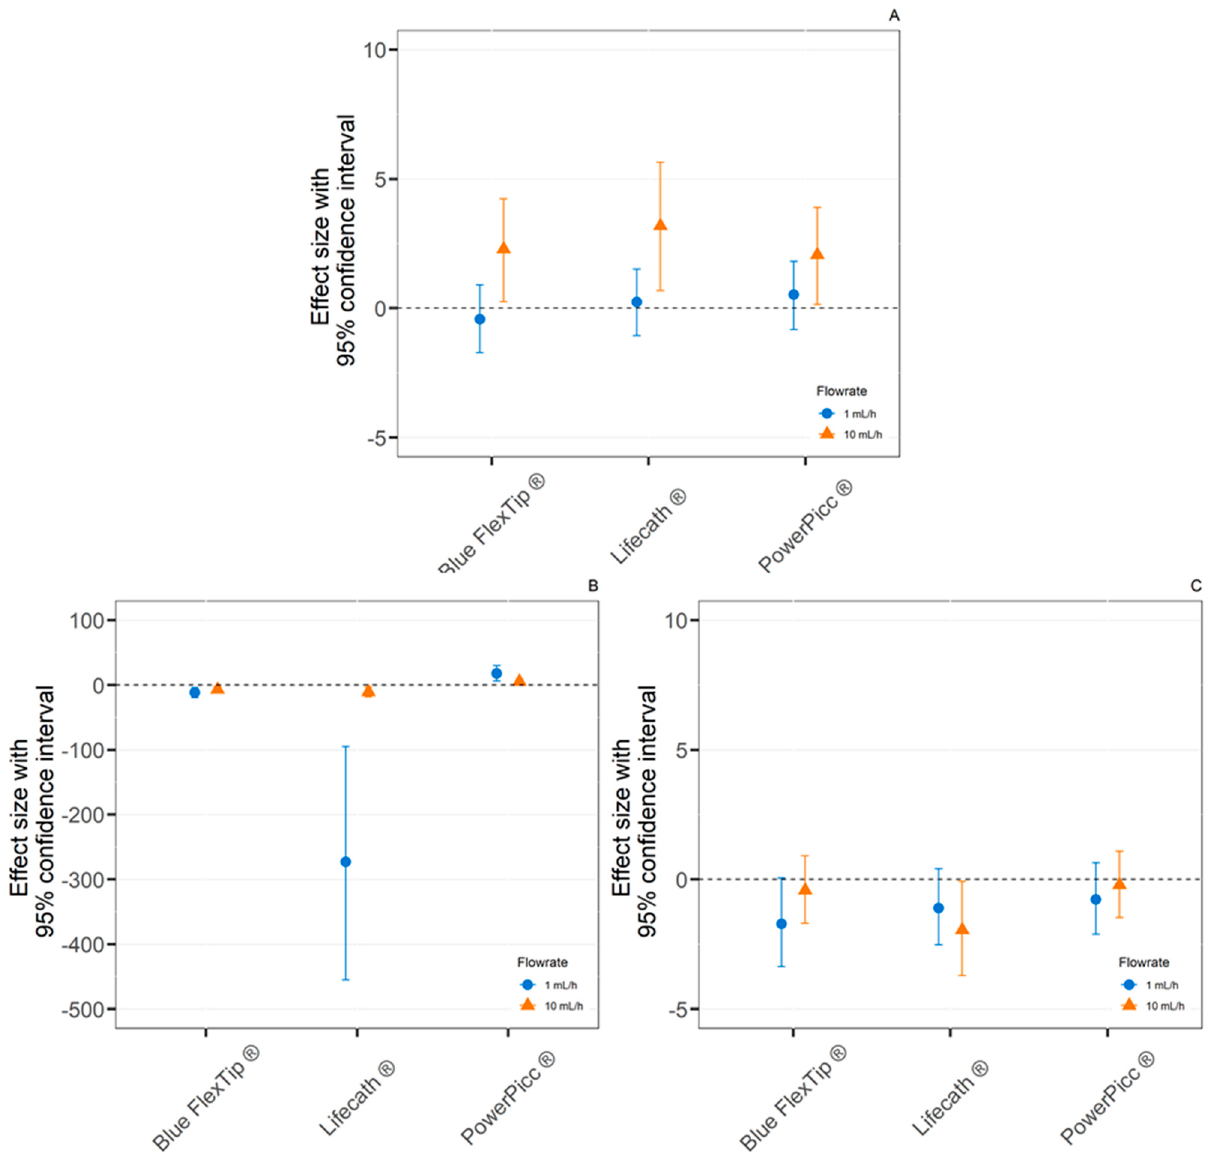
Figure 5. Effect size of the comparison between Turbo-Flo ® catheter and other studied catheters after an 8h infusion at 1 mL/h and 10 mL/h of paracetamol ( A ), diazepam ( B ), and insulin ( C ). ( n = 3, mean ± 95% confidence interval).